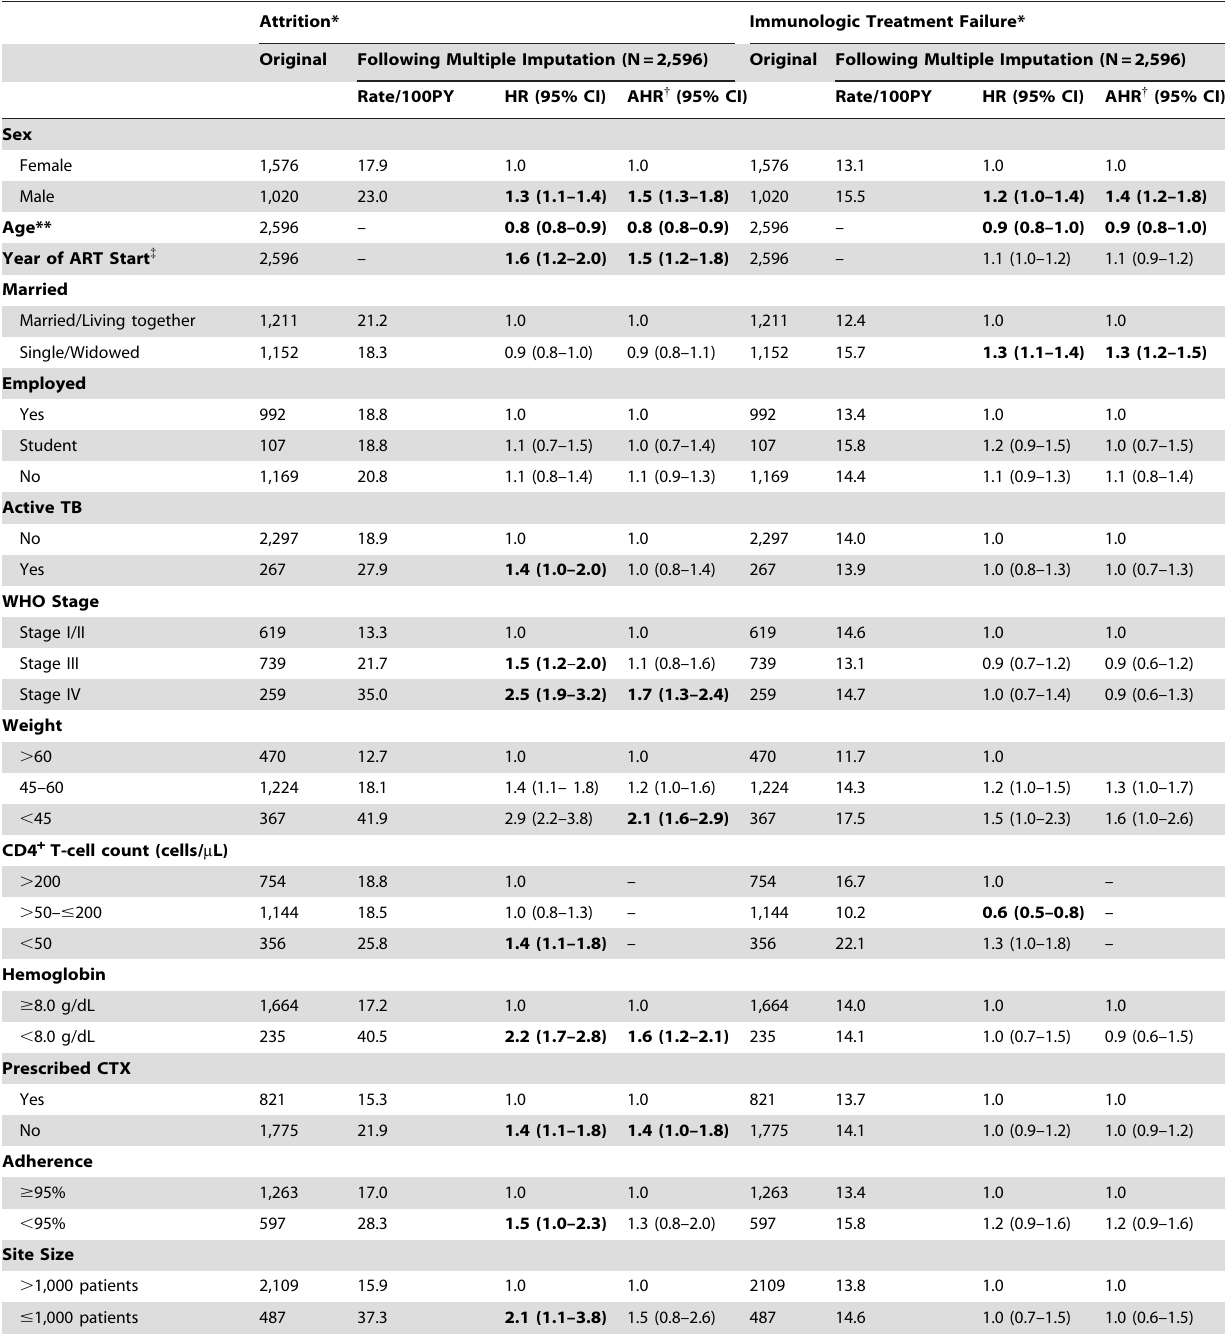
Table 2. Patient characteristics at antiretroviral therapy initiation associated with attrition and treatment